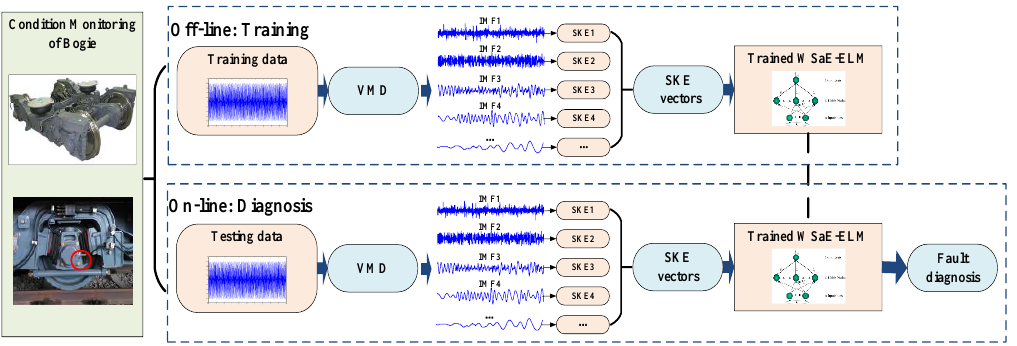
Figure 4. The scheme of the proposed method.